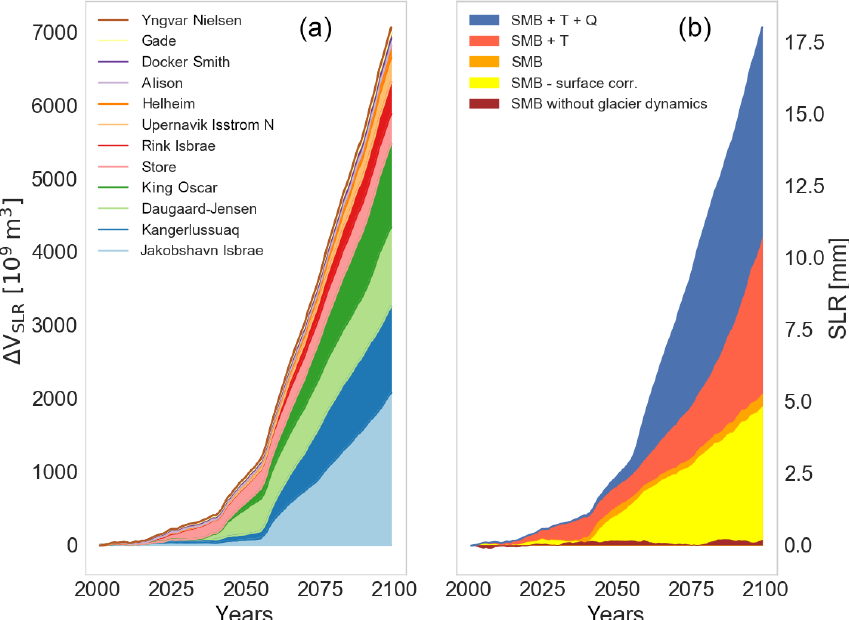
Figure 8. Cumulative sea level rise of median range (see footnote 1) SLR scenario from Fig. 7 for all 12 glaciers. (a) Individual glaciers’ response to a complete future forcing scenario (SMB, subglacial discharge Q and ocean temperature T ). (b) The role of individual forcing factors for all glaciers. The dynamics response of all 12 glaciers forced by SMB + T + Q (blue), SMB + T (pink), SMB forcing only (orange) and SMB without the surface elevation feedback in the glacier model (yellow). The static cumulative SMB anomaly over fixed present-day glacier domains and surface heights from MAR for all 12 glaciers (brown).